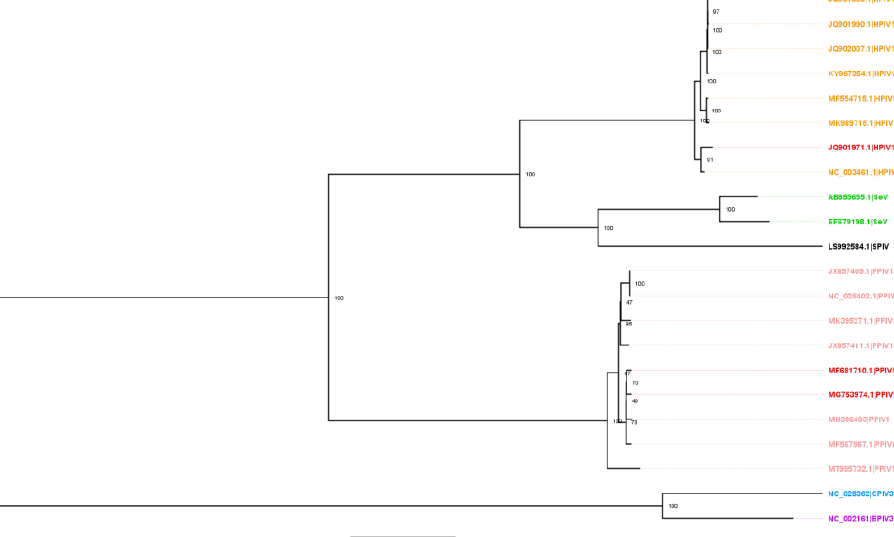
Figure 1. Maximum likelihood phylogenetic tree of whole-genome sequences from porcine parain- fluenza virus 1 (PPIV1; pink), Sendai Virus (SeV; green), Giant squirrel parainfluenza virus (SPIV; black), caprine parainfluenza virus 3 (CPIV3; blue), bovine parainfluenza virus 3 (BPIV3; purple), and Human parainfluenza virus 1 (HPIV1; orange). Maximum likelihood bootstrap support values are shown at each node. The red sequences correspond to the isolates used for challenge including JQ901971.1 (HPIV1), MG753974.1 (IA17), and MF681710.1 (MN16).